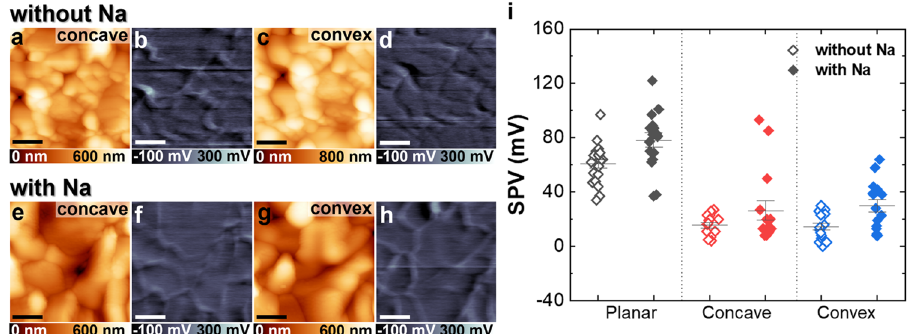
Fig. 7 Surface photovoltage (SPV) of CZTSSe fl exible solar cells under different bending modes. a – h Surface topography ( a , c , e , g ) and local SPV variation map ( b , d , f , h ) of Na-undoped and doped CZTSSe in the concave and convex states. (scale bar: 1 μ m) i Surface photo- voltage (SPV) at GBs for CZTSSe with and without Na. Reproduced with permission 112